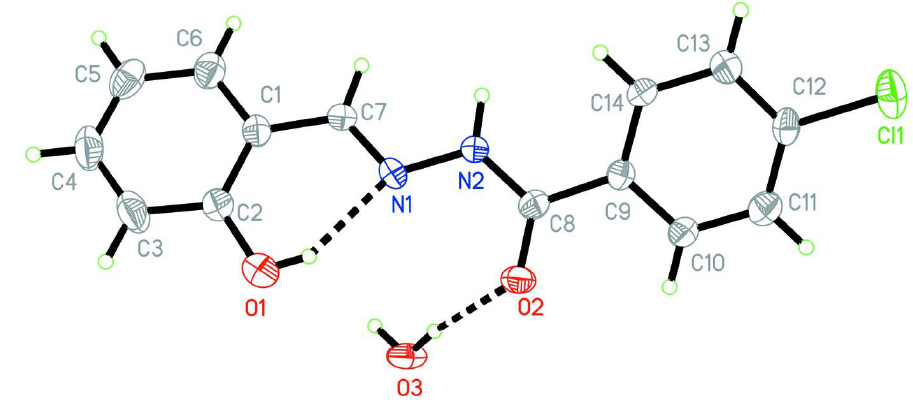
Figure 1 The molecular structure of the title compound, showing 30% probability displacement ellipsoids and the atom-numbering scheme. Dashed lines indicate hydrogen bonds.